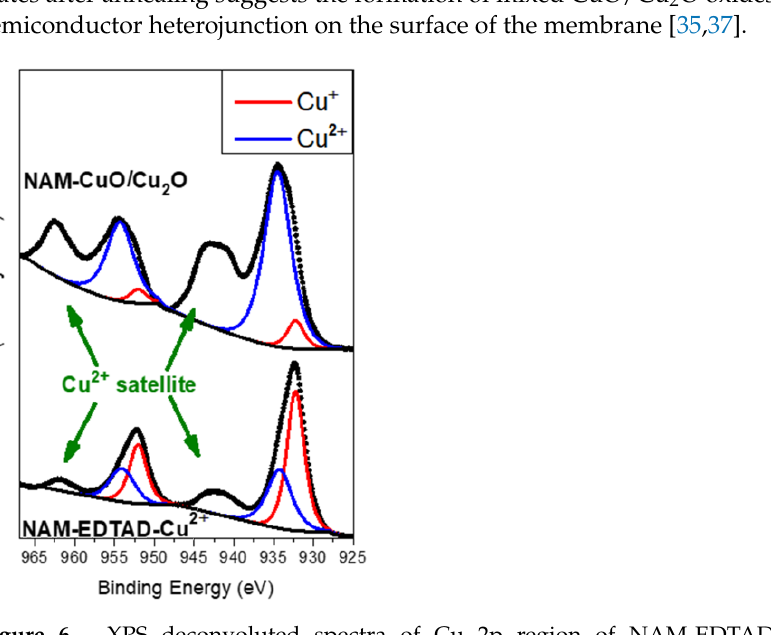
Figure 6. XPS deconvoluted spectra of Cu 2p region of NAM-EDTAD-Cu 2+ and NAM-CuO/Cu 2 O samples.